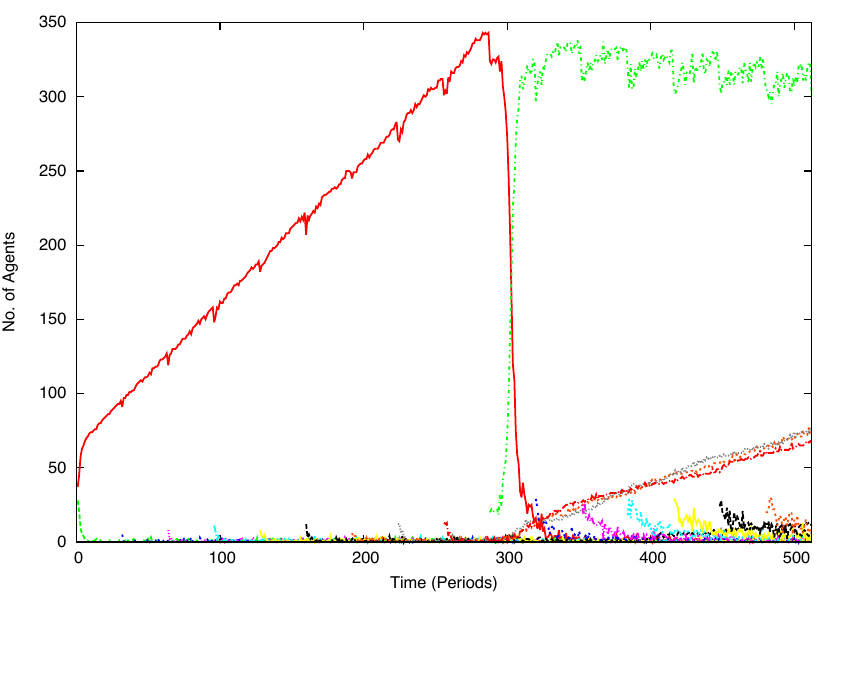
Figure 3. Development of the number of adherents to the different institutions (shown in different colors) for ↵ = 1 . 3 .